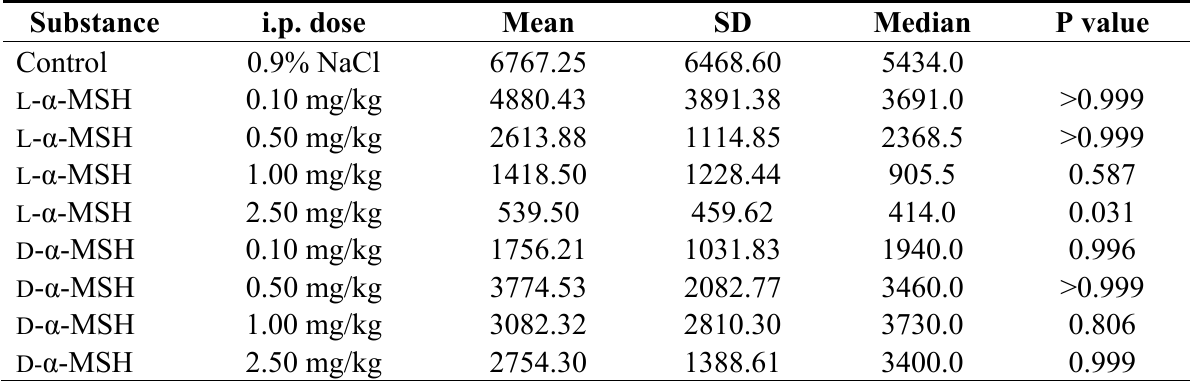
Table 1. Aspartate aminotransferase activity (U/L) in plasma of the control and α -MSH treated animals 24 h after acetaminophen administration.